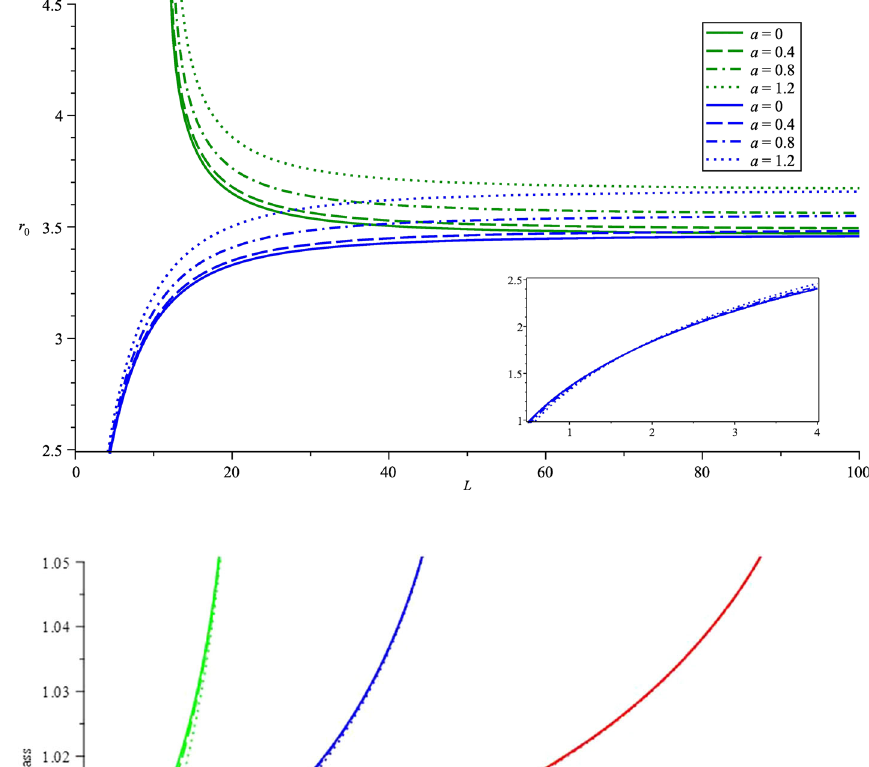
Fig. 2 Horizon radius r 0 in AdS (blue) and dS (green) with parameters Q 2 + P 2 = 12. The dS space increases the horizon radius while the AdS space decreases the radius. But the horizon radius approaches the flat space limit when the radius of the (A)dS space becomes large. The rotation increases the horizon radius both in the (A)dS space